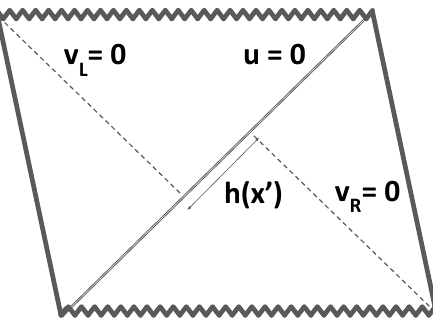
Figure 2 . Two halves of eternal AdS black hole, glued together along the shock at u = 0. There is a discontinuity in v coodinate as we pass through the shock, with v L = v R + h ( x 0